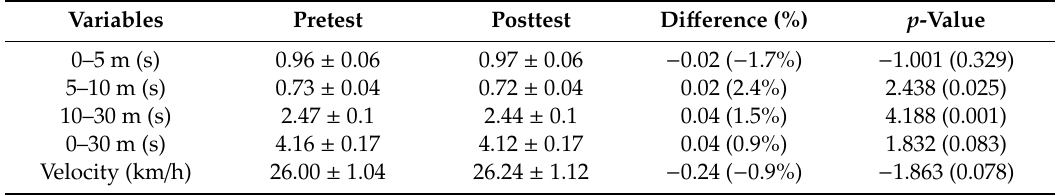
Table 5. Results of the running speed and acceleration tests in the group of football players (n = 20)